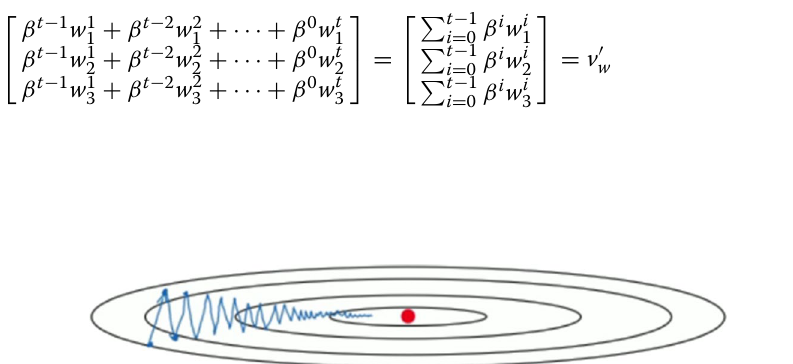
Fig. 2 The traditional gradient descent method training